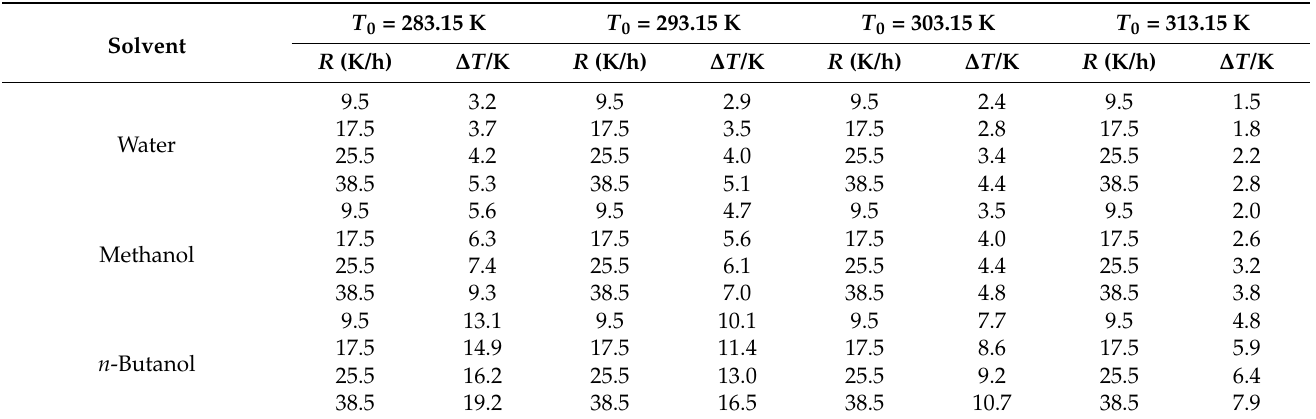
Table 3. Experimental MSZW of adipic acid from 283.15 K to 313.15